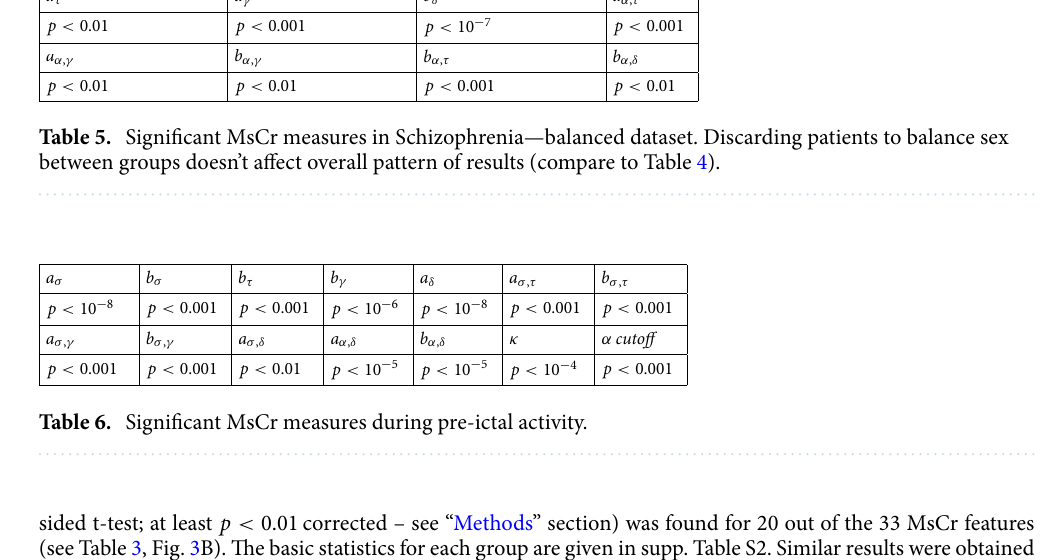
Table S4. Similar results were obtained also using non-parametric tests (supp. Table S5/S6).